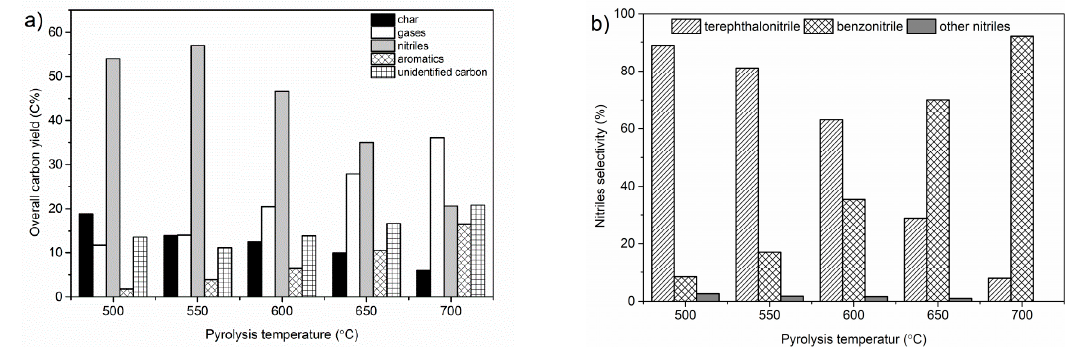
Figure 1. Effect of temperature on ( a ) overall yield and ( b ) nitriles selectivity (2% Ca(OH) 2 /Al 2 O 3 (1 g); 80 mL/min N 2 and NH 3 flow rate, 0.5 g polyethylene terephthalate (PET) /batch).